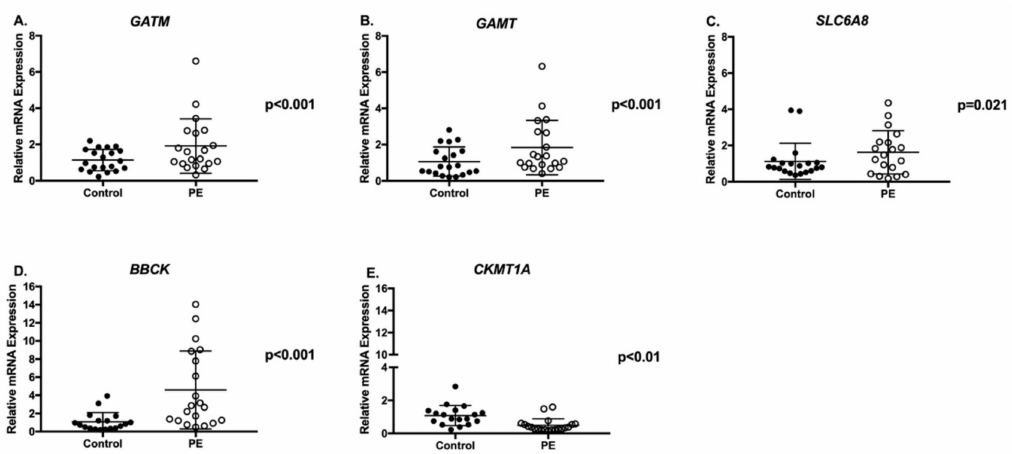
Figure 2. Placental Gene Expression of the Creatine Synthesizing Enzymes, the Creatine Transporter and Kinases. Creatine synthesizing enzymes GATM gene that codes for AGAT ( A ) and GAMT ( B ), the creatine transporter SLC6A8 ( C ), cytosolic creatine kinase BBCK ( D ) and mitochondrial creatine kinase CKMT1A ( E ). n = 20 normotensive control (closed circle) and n = 20 PE (open circle). Data are presented relative to the control cohort. Values are mean ± SD. Wilcoxon Rank Sum was used for statistical comparison. Significance was set at p ≤ 0.025, following a Benjamini-Hochberg adjustment for false-positives.